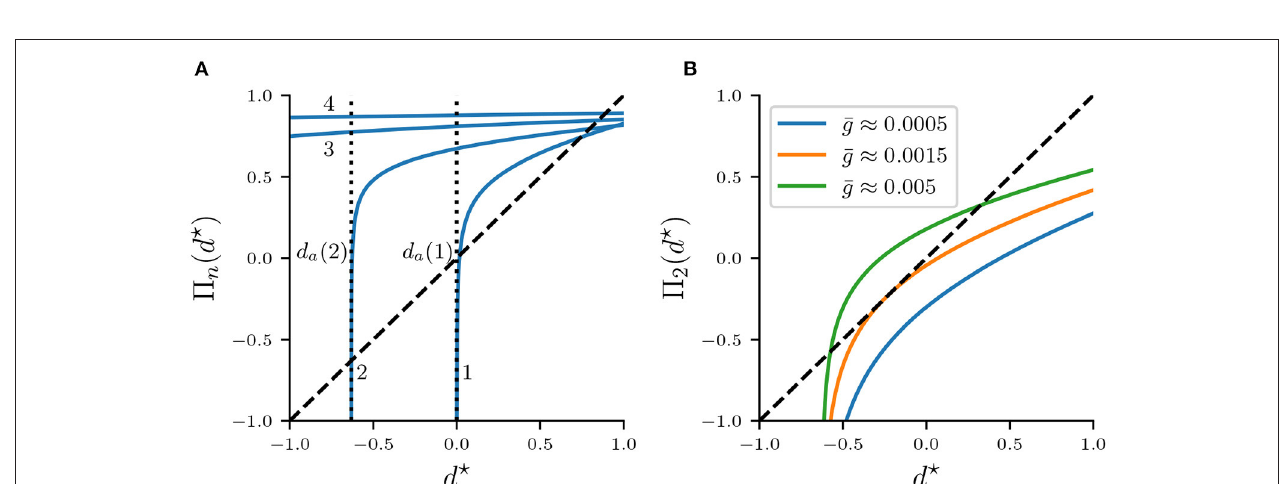
of 5 n with the diagonal are fixed points of the map. Figure 8B shows 5 2 with n = 2. Varying the synaptic strength ¯ g moves